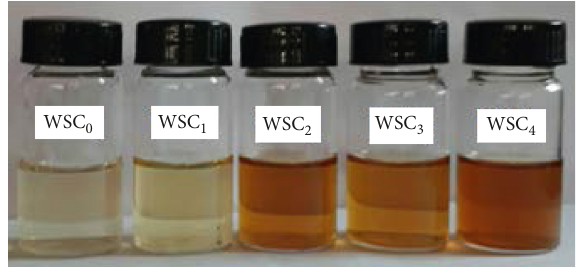
Figure 2: WSC samples dissolved in water at 25 ° C with the concentration 0.5% (w/v). Table 2: DD and soluble time of WSC samples and CTS